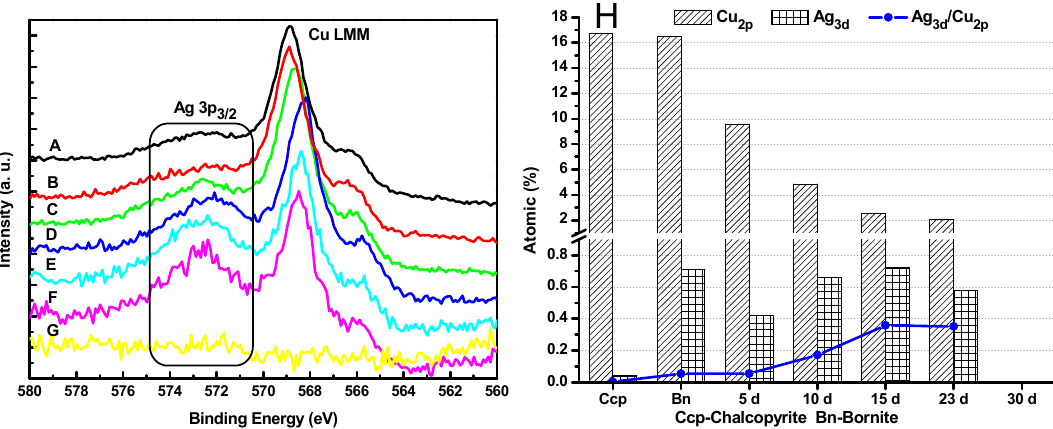
Figure 5. Copper Auger spectra (Cu LMM) peaks of co-bioleaching chalcopyrite and bornite (ratio of Ccp/Bn was 3:1). ( A ) bornite, ( B ) chalcopyrite, ( C ) 5 days, ( D ) 10 days, ( E ) 15 days, ( F ) 23 days, ( G ) 30 days. ( H ) Atomic percentage of Cu 2p and Ag 3d on the surface of bioleaching residues. Data source: survey (full range) XPS spectra.